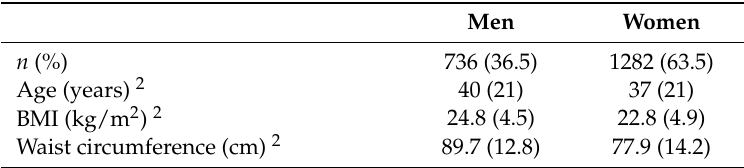
Table 2. Sample characteristics 1